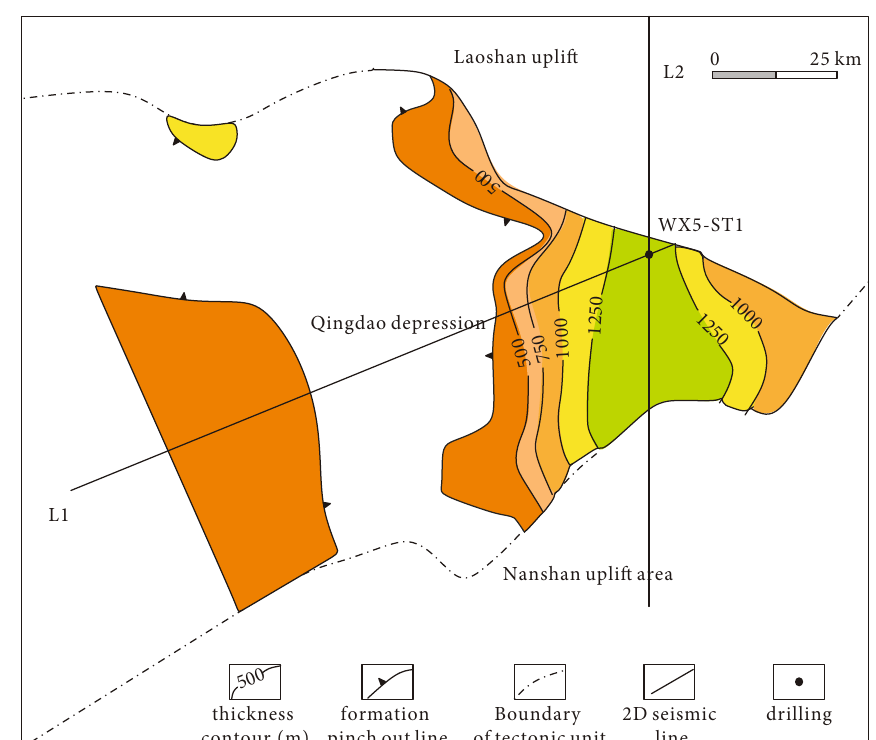
Figure 6: Triassic residual thickness and its distribution in the southern depression of the South Yellow Sea Basin